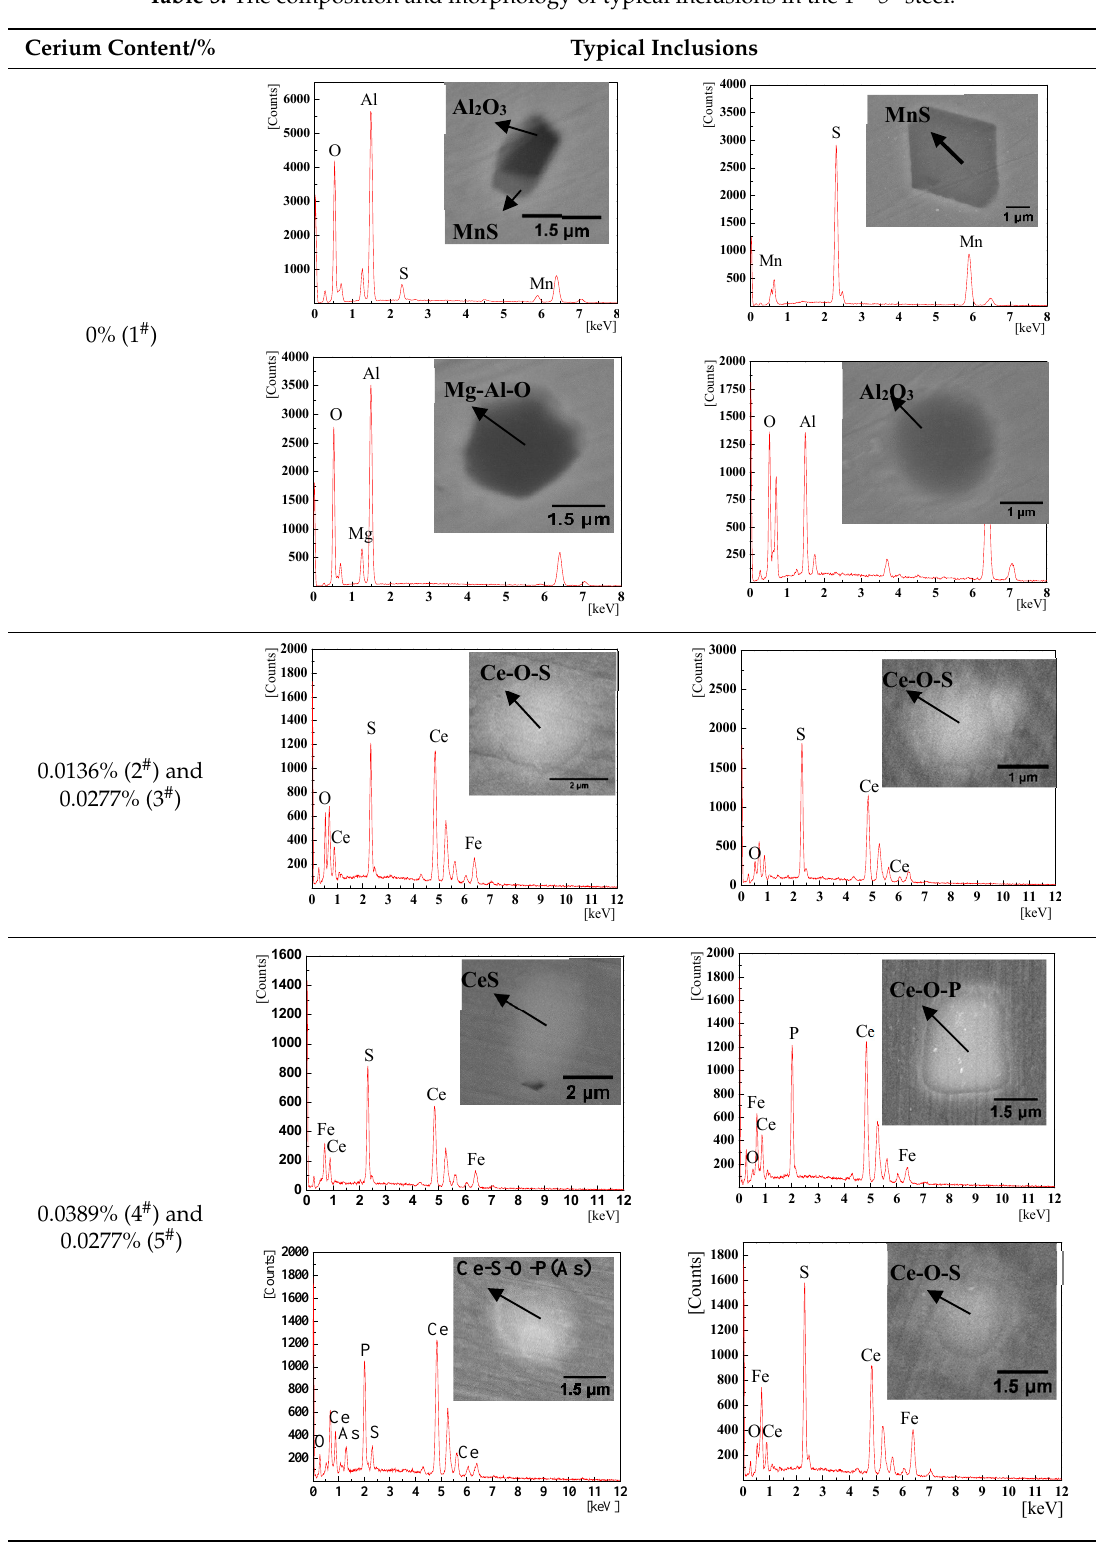
Figure 3. Data points of the 2 # ~5 # heats in a phase stability diagram of the inclusions bearing cerium. Table 5. The composition and morphology of typical inclusions in the 1 # ~5 # steel. Cerium Typical Inclusions Content/%